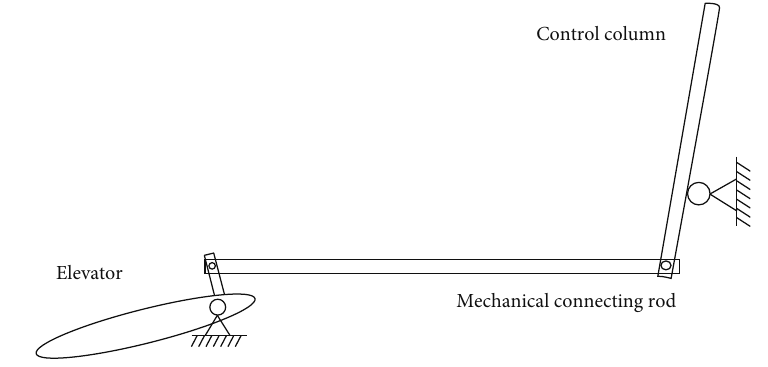
Figure 1: Working principle of mechanical